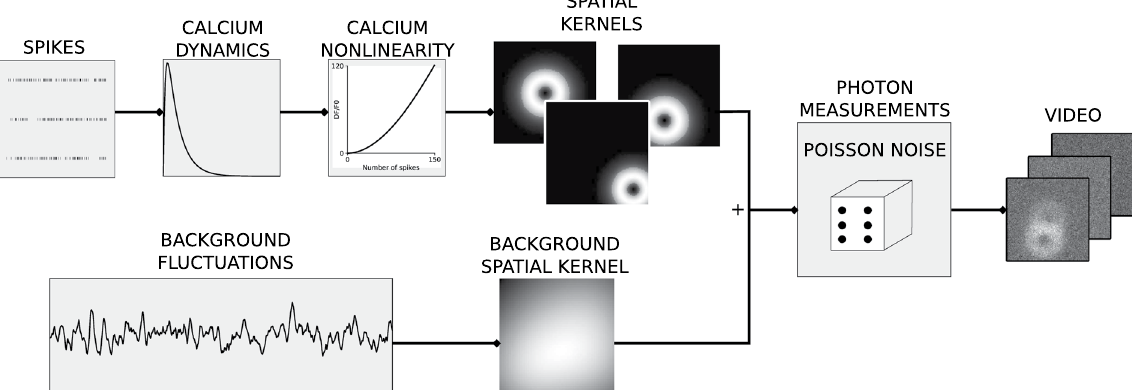
Figure 6. Simulated data generation. For each simulated neuron, a Poisson spike train is generated. The corresponding calcium indicator dynamics are simulated using GCaMP6 rise and decay times, and a nonlinearity. Next, the calcium traces are associated with a spatial kernel consisting of a doughnut shape mask (that models the cellular soma’s structure) and a Gaussian that simulates signal spread. Additionally, noisy background fluctuations are generated which vary spatially through a spatial kernel. All resulting signals are summed, and passed through a Poisson generation process to simulate photon emission, resulting in the final image